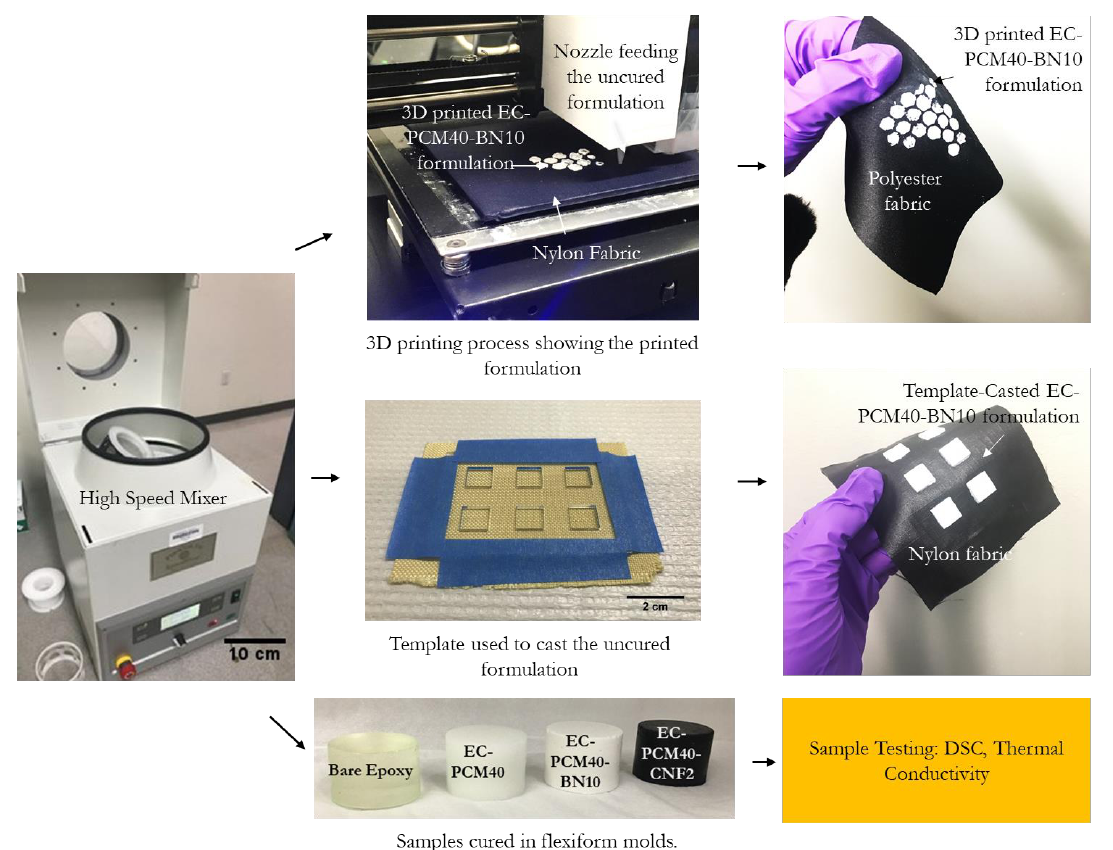
Figure 8. Images showing the asymmetric mixer, the three-dimensional (3D) printing setup, and printed